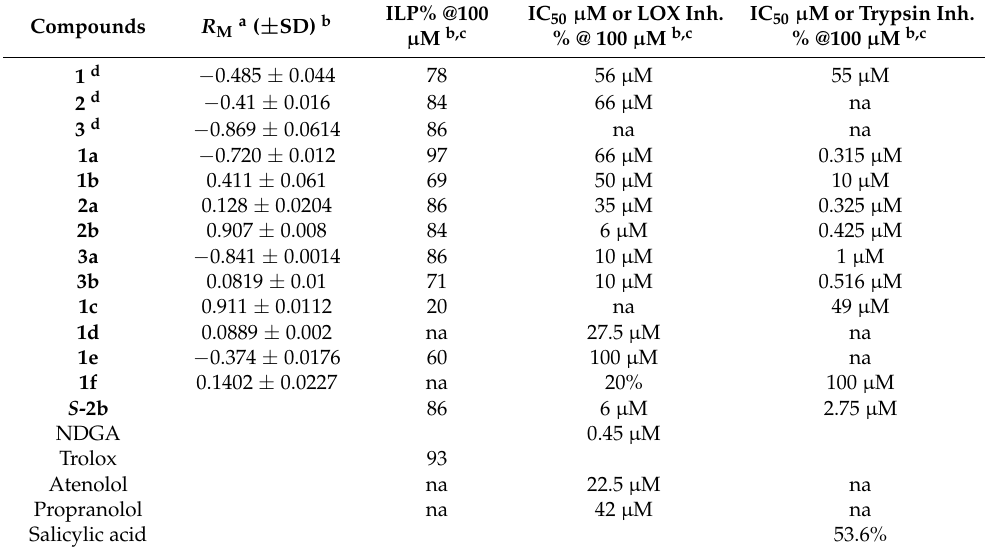
Table 1. Lipophilicity ( R M values), % Inhibition of lipid peroxidation (ILP%), in vitro inhibition of soybean lipoxygenase (IC 50 µ M or LOX Inh. %) and in vitro inhibition of trypsin induced proteolysis (IC 50 µ M or Trypsin Inh. %) by cinnamic derivatives.